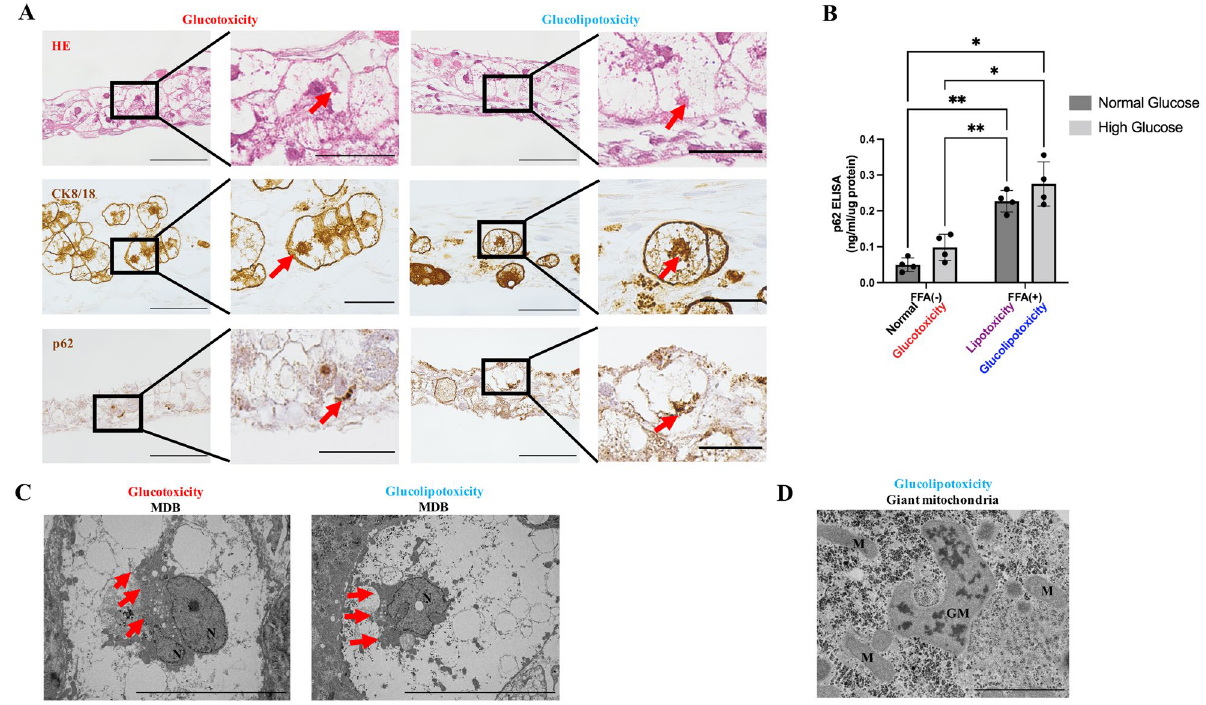
Figure 5. Identification of MDBs in vitro. ( A ) Representative images of HE staining and immunofluorescence staining. Eosinophilic bodies and CK8/18 aggregates were observed in glucotoxicity, lipotoxicity, and glucolipotoxicity groups. However, p62-positive bodies were identified only in the glucotoxicity and glucolipotoxicity groups. Red arrows indicate MDBs. Scale bar, 100 μm in normal views. Scale bar, 50 μm in enlarged views. HE: Hematoxylin–eosin, CK: Cytokeratin. ( B ) p62 protein quantification in PHH/HSC sheets by ELISA. p62 levels were significantly higher in the lipotoxicity and glucolipotoxicity groups compared to control and glucotoxicity groups. n = 4, 3 independent experiments, ** p < 0.01, * p < 0.05. ( C ) Representative images of TEM. Red arrows indicate MDBs. MDBs were observed in the glucotoxicity and glucolipotoxicity groups. Scale bar, 10 μm. N: nuclear. ( D ) Representative images of TEM. Giant mitochondria was observed in the glucolipotoxicity group. Scale bar, 2 μm. M: mitochondria, GM: giant mitochondria with crystalline